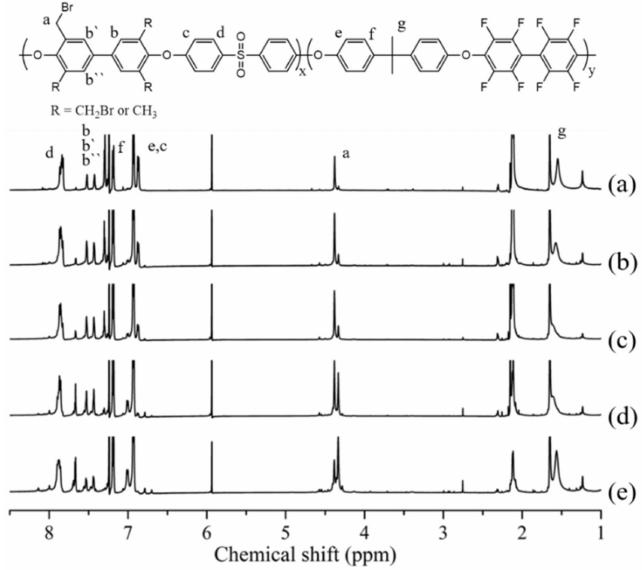
Figure 3. 1 H-NMR of ( a ) Br-PAES-10%, ( b ) Br-PAES-20%, ( c ) Br-PAES-30%, ( d ) Br-PAES-40%, ( e )